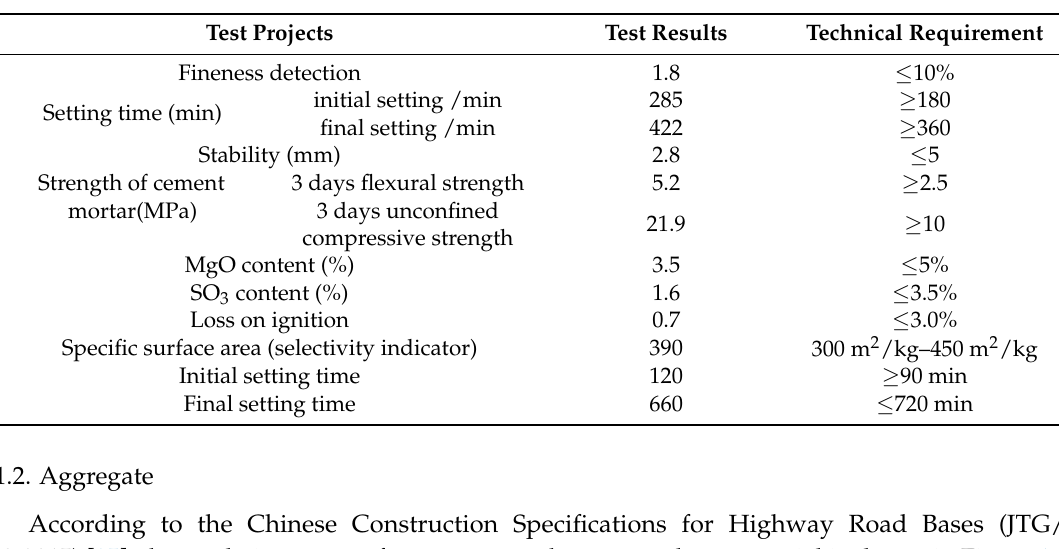
Table 2. The aggregate content of cylinder specimen.